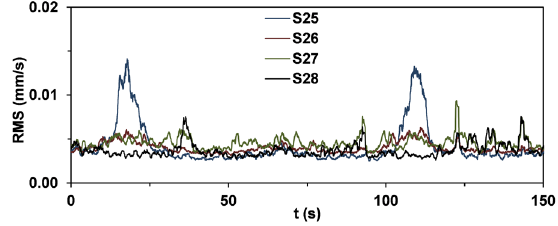
Figure 17. RMS of vertical recordings V25 to V28 in configuration C4.